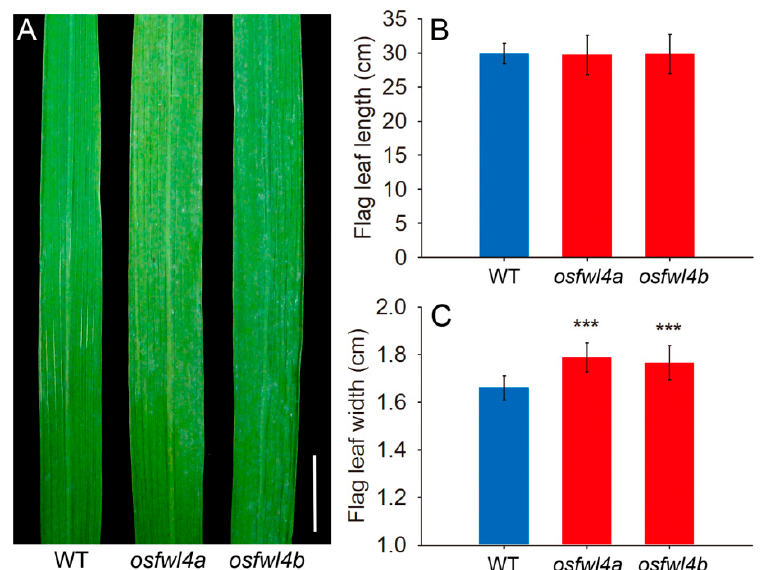
Figure 3. Phenotypes of flag leaves of WT and OsFWL4 gene mutants. ( A ) Flag leaves of the WT and mutants, bar = 2 cm. ( B ) Flag leaf length of the WT and mutants. ( C ) Flag leaf width of the WT and mutants. The values in ( B ) and ( C ) are means of 20 plants. Error bars are standard deviations. *** p < 0.001.